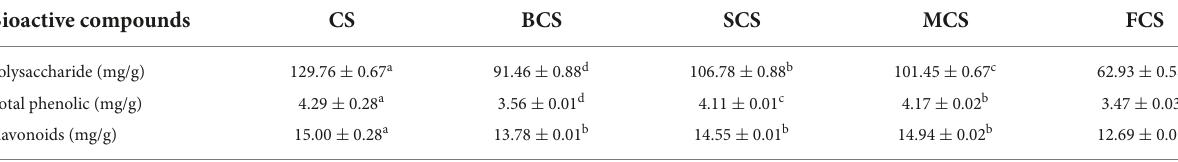
TABLE 6 Effects of different cooking methods on bioactive compounds contents in C. squamulosa. Bioactive